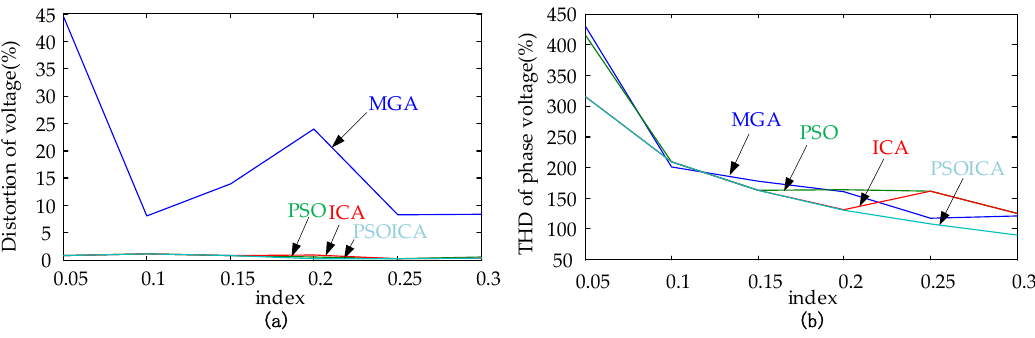
Figure 6. Characteristic analysis: ( a ) voltage distortion rate; ( b ) THDs.